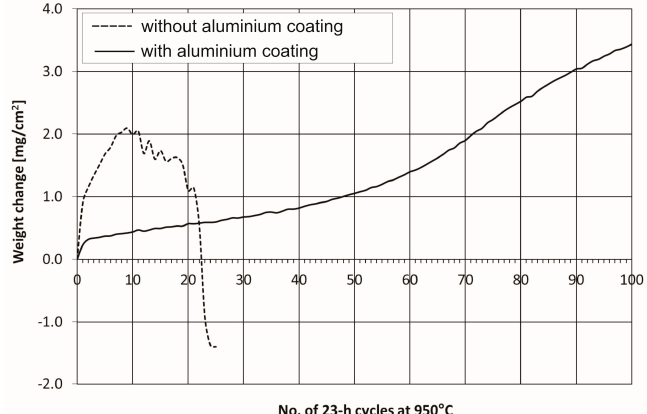
Figure 9. Mass change vs number of cycles at 950 °C for the bare and aluminium coated Ti–45Al– 8Nb–0.5(B, C) alloy.